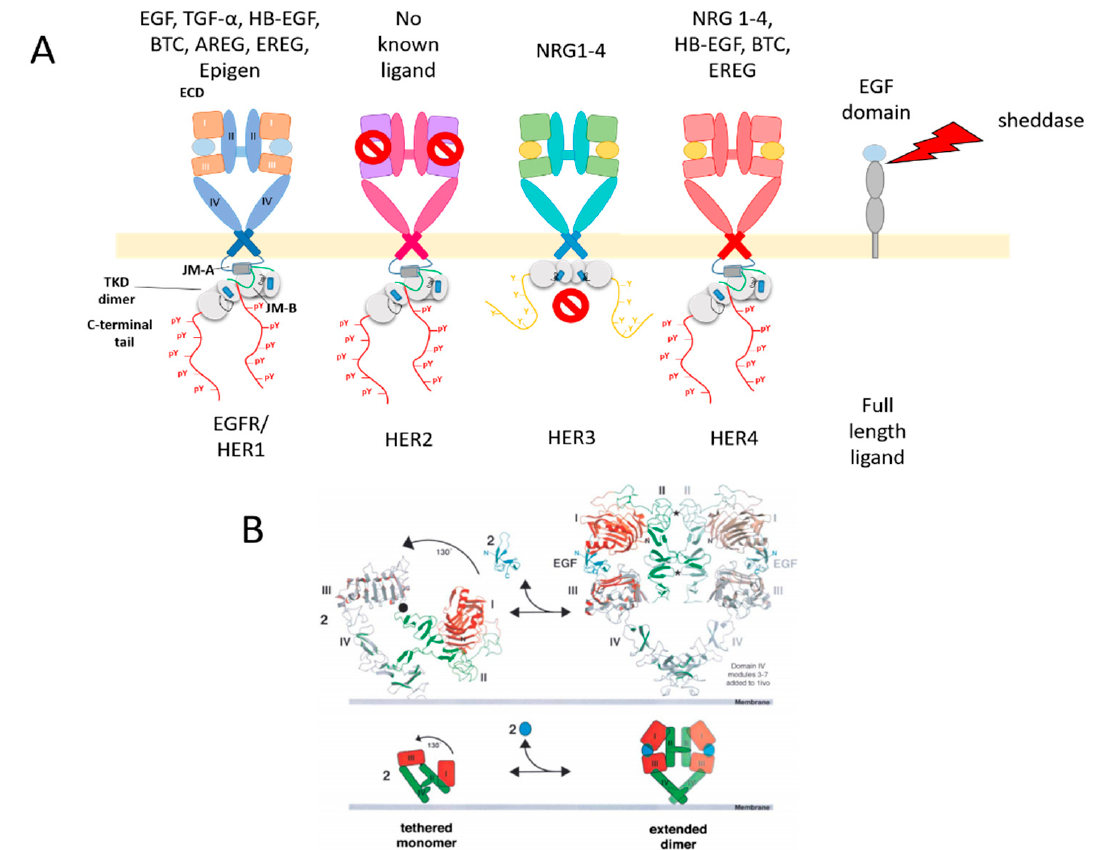
Figure 2. The EGFR family: ( A ) Cartoons of EGFR family homodimers showing the extracellular domain in its back-to-back dimer conformation, bound to ligand where applicable, and the intracellular asymmetric tyrosine kinase dimer, joined by the Transmembrane Domain (TMD). The latter leads to phosphorylation of tyrosines on the C-terminal tail (yellow dots) and recruitment of e ff ectors (red, teal, orange and lime green shapes). The red “no entry” symbols indicate the lack of a known soluble ligand for HER2 and the pseudokinase status of HER3. Also shown is a cartoon of a full-length, transmembrane EGFR family (pro)ligand. ( B ) Molecular model view (above) and cartoon view (below) of the conformational changes involved in ligand-induced dimerisation in the EGFR receptor, adapted from Martin-Fernandez M. et al.,